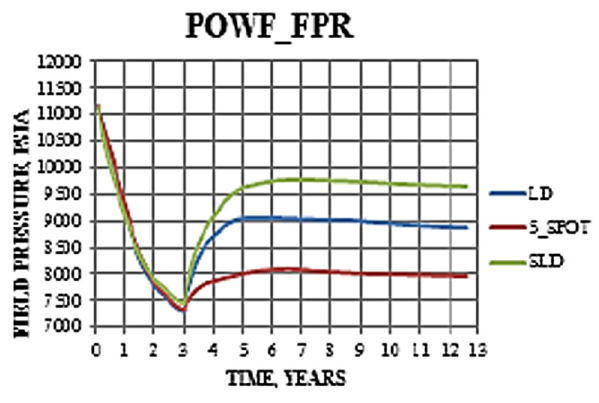
Fig. 21 Plot of average field pressure versus time for different